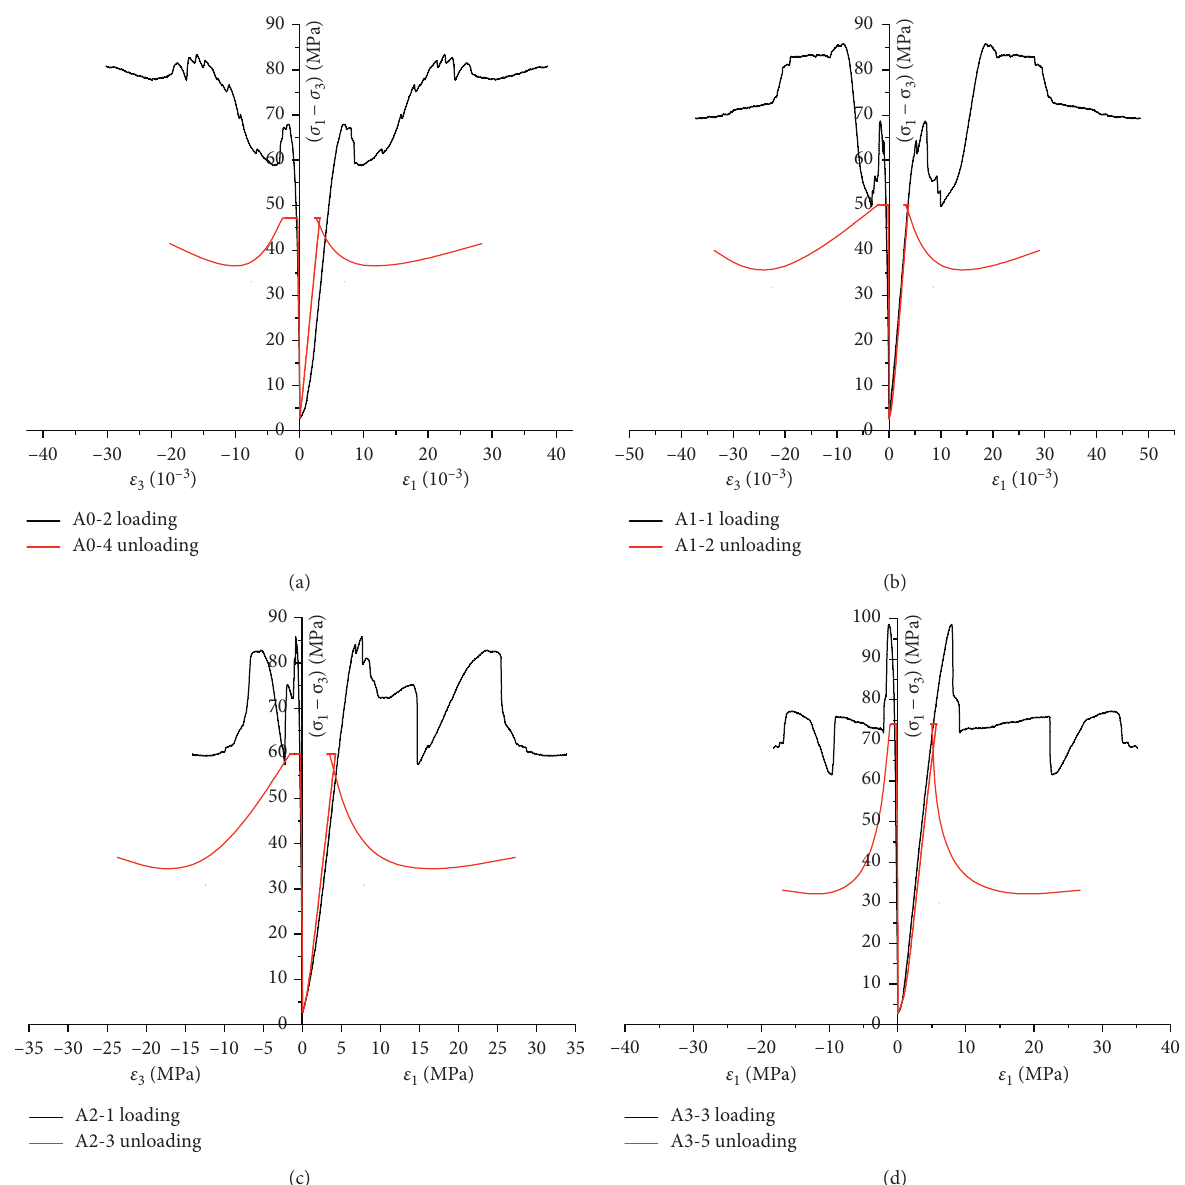
Figure 6: Stress-strain curves of rock-like specimens with preexisting fissures under type I and II tests. (a) α � 0 ° . (b) α � 30 ° . (c) α � 60 ° . (d) α � 90 °